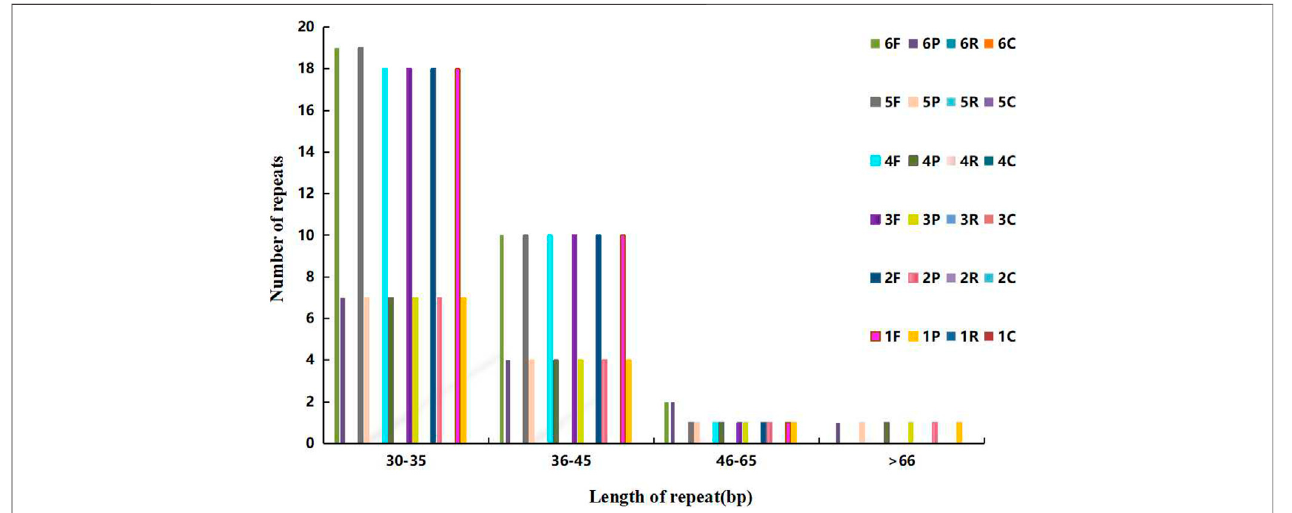
FIGURE 4 | Distributions of the dispersed repeat. The x-coordinate is the length of dispersed repeats, and the y-coordinate is the number of dispersed repeats. 1 – 6: A. cristatum × A.desertorum Fisch.Schult, A. desertorum , A. desertorum Fisch. Schult, A.michnoi , A. mongolicum ,and A. cristatum .Fstandsfor forward repeats, P for palindromic repeats, R for reverse repeats, and C for complementary